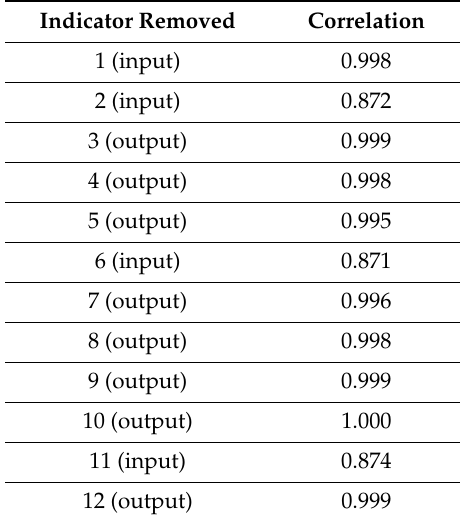
Table 9. Spearman’s rank correlation coe ffi cients (rho) between vectors of average e ffi ciencies when removing the 12 indicators one by one. All correlation coe ffi cients are significant at the 0.01 level. Indicator